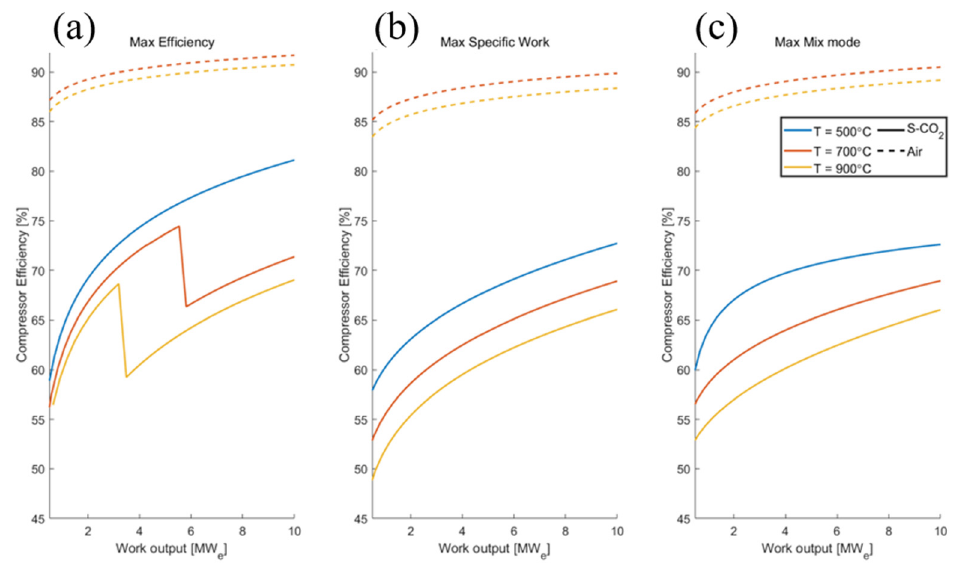
Figure 30. Compressor Efficiency for ( a ) maximum efficiency, ( b ) maximum specific work, and ( c )